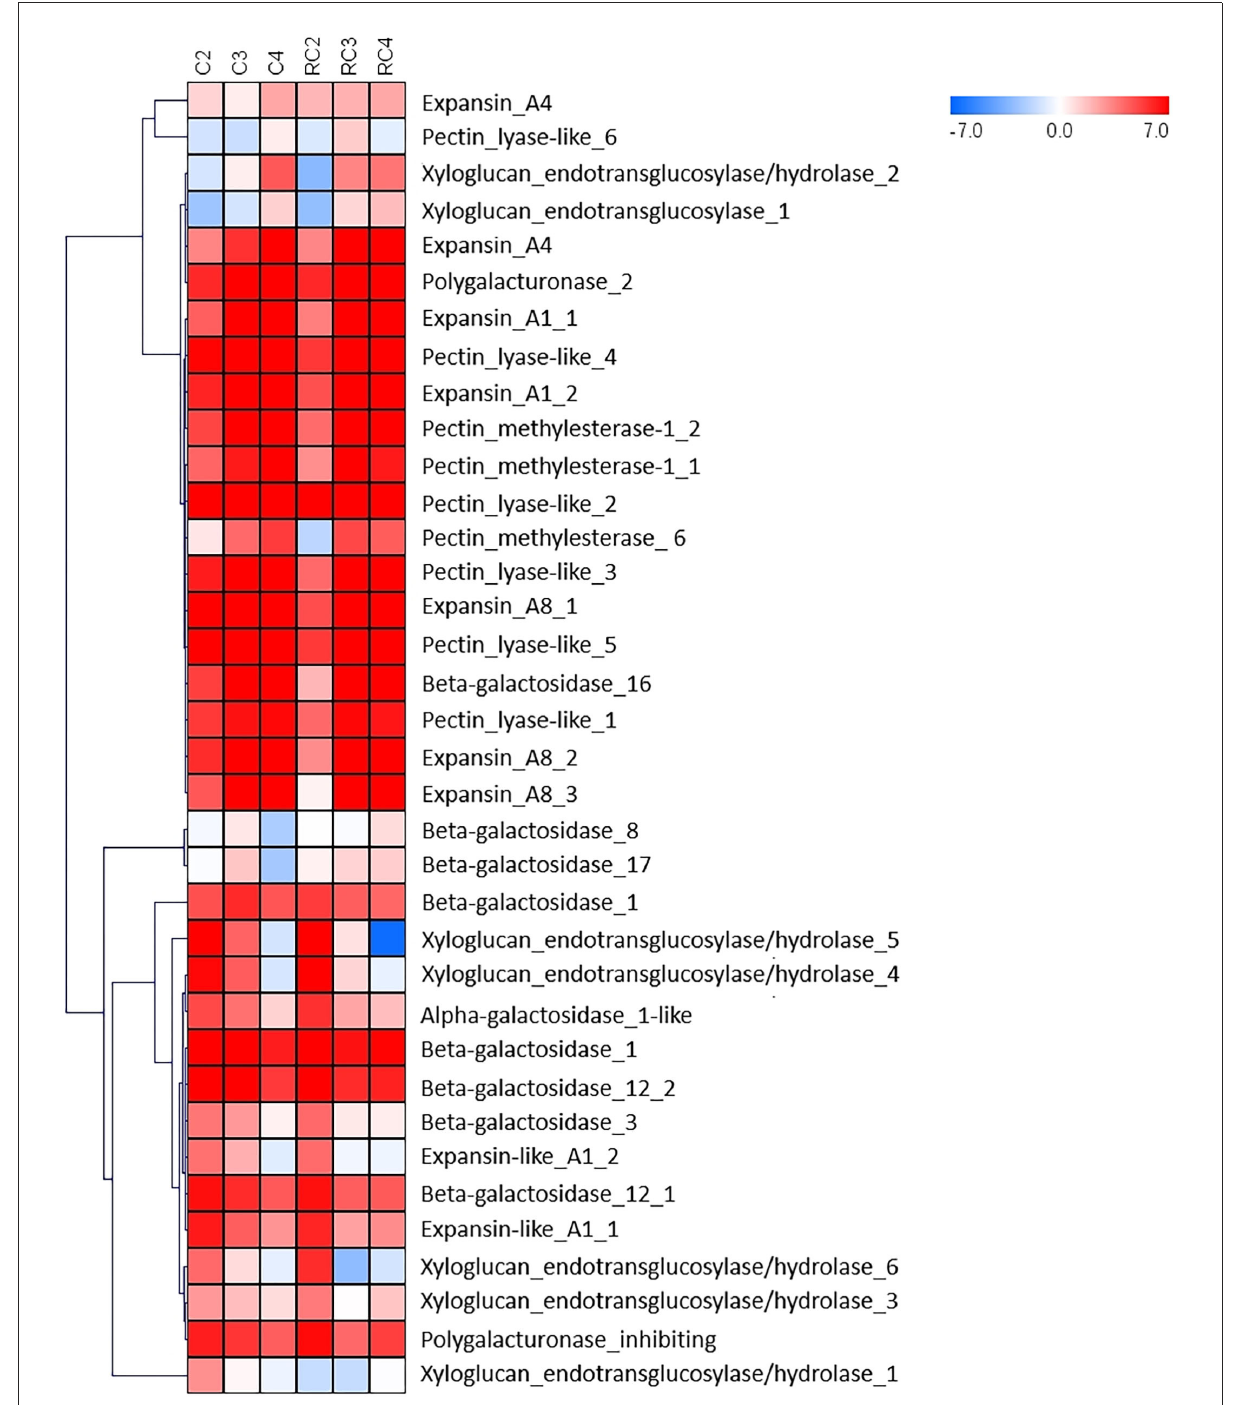
FIGURE7 HeatMap for genes involved in the dynamics of the cell wall. Log2 is calculated to the FPKM value for each gene to delimit extreme values and used to scale expression. To perform hierarchical clustering for fruit developmental stage and tissue type (receptacle and receptacle without achene), we selected the Pearson Correlation distance metric and average linkage clustering. Levels of decreased expression are shown in blue and increased expression is shown in